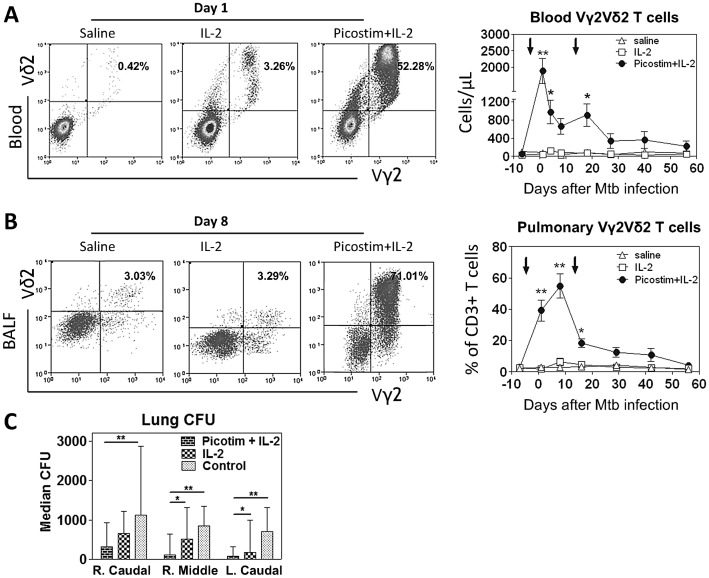
Intermittent Picostim/IL-2 administration during early pulmonary Mtb infection induced major expansion of Vγ2Vδ2 T cells and accumulation of them in pulmonary compartment, and led to reduction in Mtb bacterial burdens in lungs.(a) Representative flow histograms of percentages of Vγ2Vδ2 T cells gated on CD3(left) at day 1 postinfection (day 4 after 1st treatment) and graph data (right) of absolute numbers of Vγ2Vδ2 T cells over time after treatments, respectively, in the blood. Percentages of Vγ2Vδ2 T cells in CD3 T cells are indicated in right upper quadruples. Graph data are means with SEM from nine macaques/per group. Vertical arrows denote the times for treatment. **p<0.01, *p<0.05, by both parametric and nonparametric analyses. (b) BAL fluid (BALF) data in a similar fashion as (a), except that flow data are on day 8 post infection(day 11 after treatments) and that numbers in graphs (right) are percentages of Vγ2Vδ2 T cells(n = 9 for each group). Increases in Vγ2Vδ2 T cells in BALF consist with accumulation of them in lung tissues of phosphoantigen/IL-2-treated macaques ([14] and data not shown). The data suggest changes in Vγ2Vδ2 T cells in the airway of the pulmonary compartment, not precisely in lung tissues. Please see Fig. S3c in Text S1 for immunohistocheminstry in situ analysis of γδ T cells in lung parenchyma and granulomatous tissues). (c) Mean CFU counts of bacilli in lung tissue homogenates of different lung lobes collected at the end point (at day 65) from Picostim/IL-2-treated and control groups. Lung tissue homogenates generated from each lobe was serially diluted and used for CFU enumeration(CFU/ml homogenates). **p<0.01, *p<0.05, respectively, by parametric and nonparametric comparisons between Picostim/IL-2-treated and control groups(n = 9/group). Data from control groups [22] were shown here again to prove the concept that phosphoantigen/IL2 expansion of Vγ2Vδ2 T cells can more apparently limit Mtb growth compared to saline/BSA and IL2 alone controls as all groups were evaluated simultaneously.